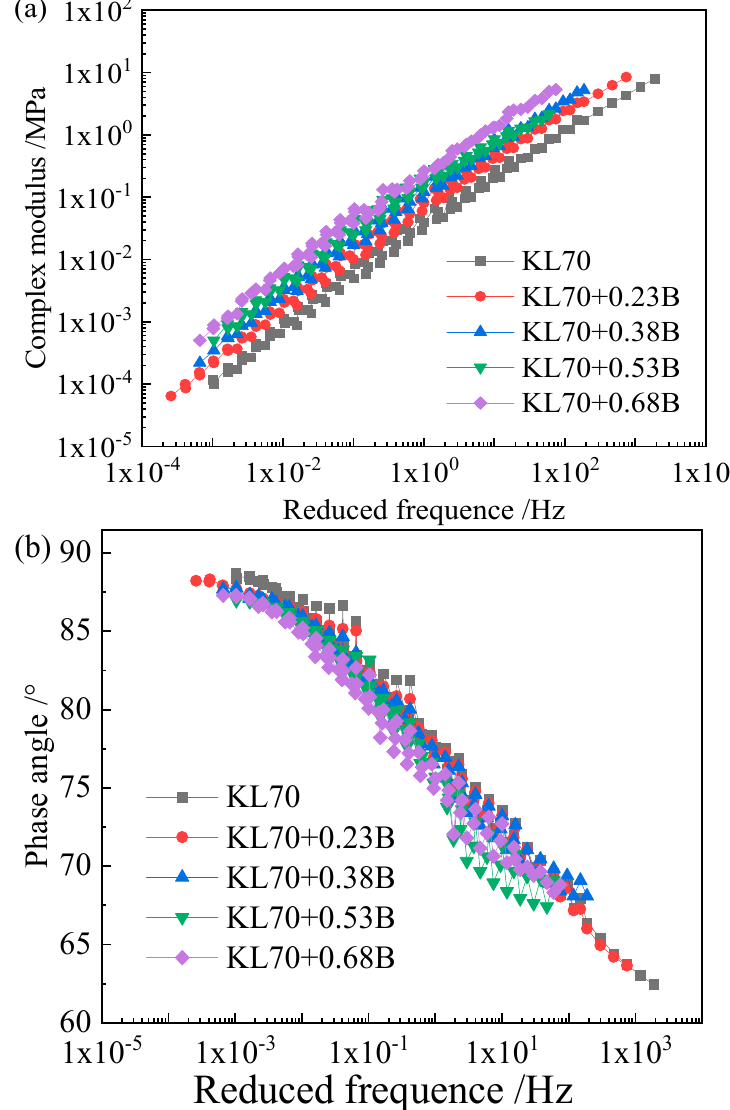
Figure 6. Master curve of complex modulus ( a ) and phase angle ( b ) of KL70 binder and mastics (B).